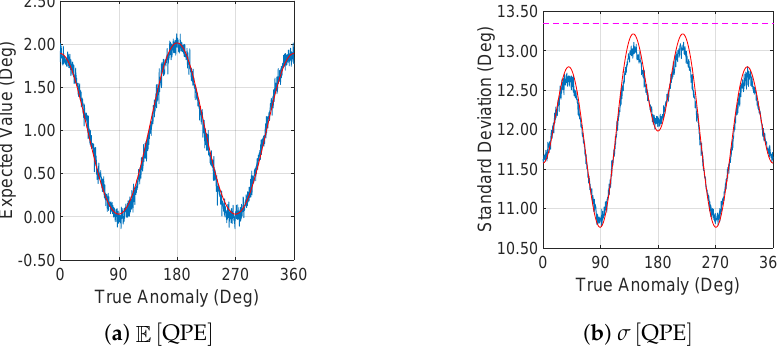
Figure 5. QPE result from numerical simulation (blue) compared with that from the analytical approximation model (red). The expected value and standard deviation of QPE are shown in ( a ) and ( b ), respectively. The dashed magenta line in ( b ) is the value of σ [ QPE ] from Equation (47). max The dashed magenta line in Figure 5b is σ [ QPE ] . This maximum value does not equal the max exact maximum of σ [ QPE ] ; instead, it has a 1.80% relative error with the given simulation